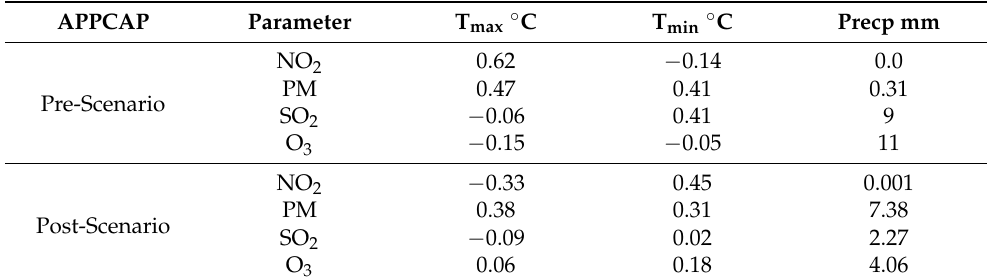
Table 2. An average value of climatic variation in response to air pollutant changes during (pre- and post-) scenarios in the study